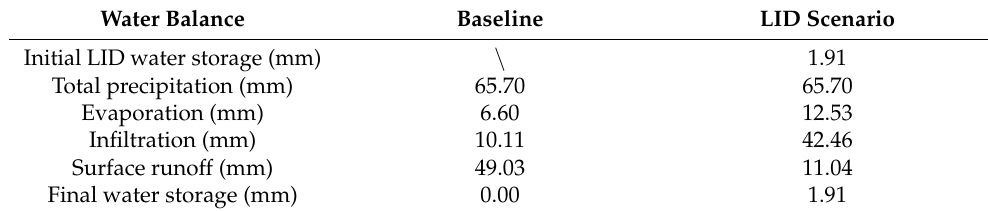
Table 9. Water budgets during the winter.